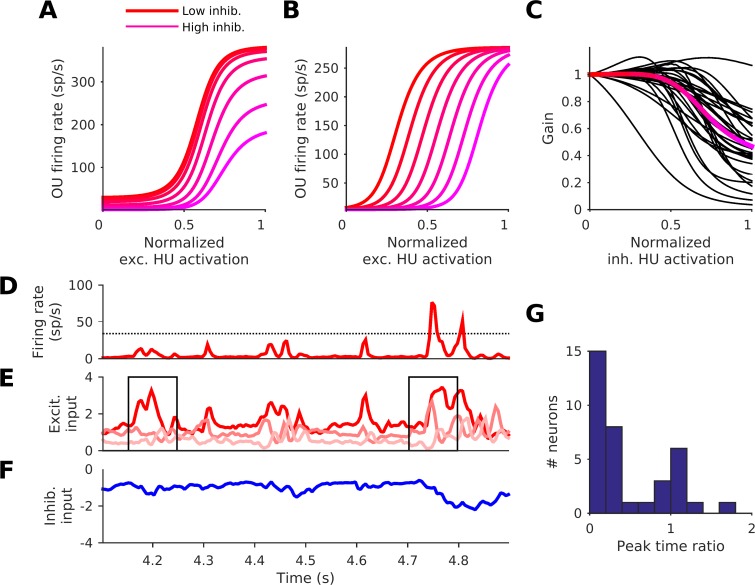
Functional implications of the neural network model fits.(A) The effect of activation of the inhibitory hidden unit (HU) on the relationship between output unit (OU) firing rate and excitatory HU activation, for an example bi-feature neuron's NRF. The steepest slope of each curve is its gain. Activation in all plots is normalized to span 0–1, where 0 is the 1st centile and 1 the 99th centile of the distribution of activations over the stimulus set (Fig 3C). (B) The effect of inhibiting the excitatory HU (instead of the OU) on the same relationship for the same example NRF. (C) The gain as a function of inhibitory HU activation for all 32 bi-feature neurons (black lines). For each neuron the gain is normalized to be 1 when the normalized inhibitory HU activation is 0. Red/magenta line: the mean. Note that the full range of excitatory HU activations, from threshold to saturation of the HU, was examined to find the steepest slopes and hence the gain (i.e. beyond the 1st and 99th centiles). (D) The OU firing rate of an NRF model fit for an example multi-feature neuron (red line). The dotted line is the 2σ-threshold. (E) The weighted-output (the input to the OU, HU output × output weight) from the 3 effective excitatory HUs. (F) The weighted-output from the single effective inhibitory HU for this neuron. (G) The distribution of peak time ratio for all multi-feature neurons. The peak time ratio is the number of times the sum of the outputs of all reduced-NRF models exceeded the 2σ-threshold, relative to the number of times the output of the full NRF did so. The reduced-NRF models of a neuron each retain just one of the excitatory HUs.